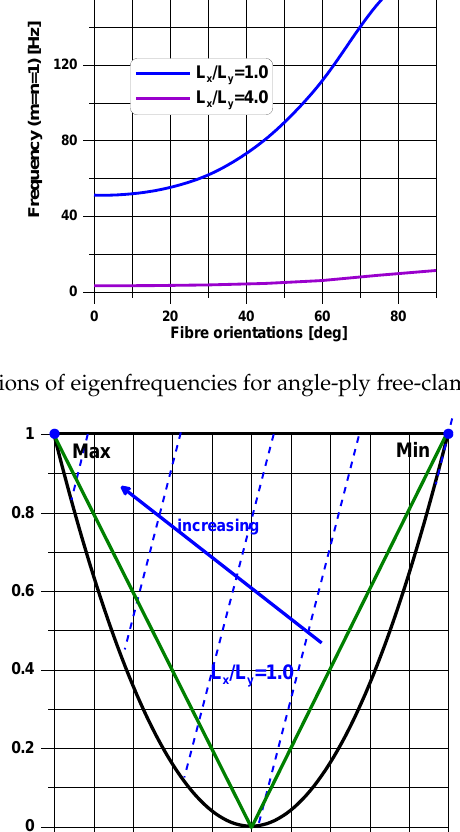
Figure 8. Contours of natural frequencies on the x , y plane for angle-ply and symmetric laminates—clamped (CCCC) plates.